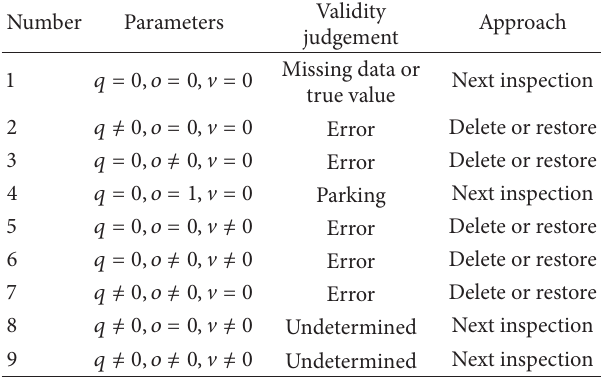
Table 1: Basic data screening based on traffic